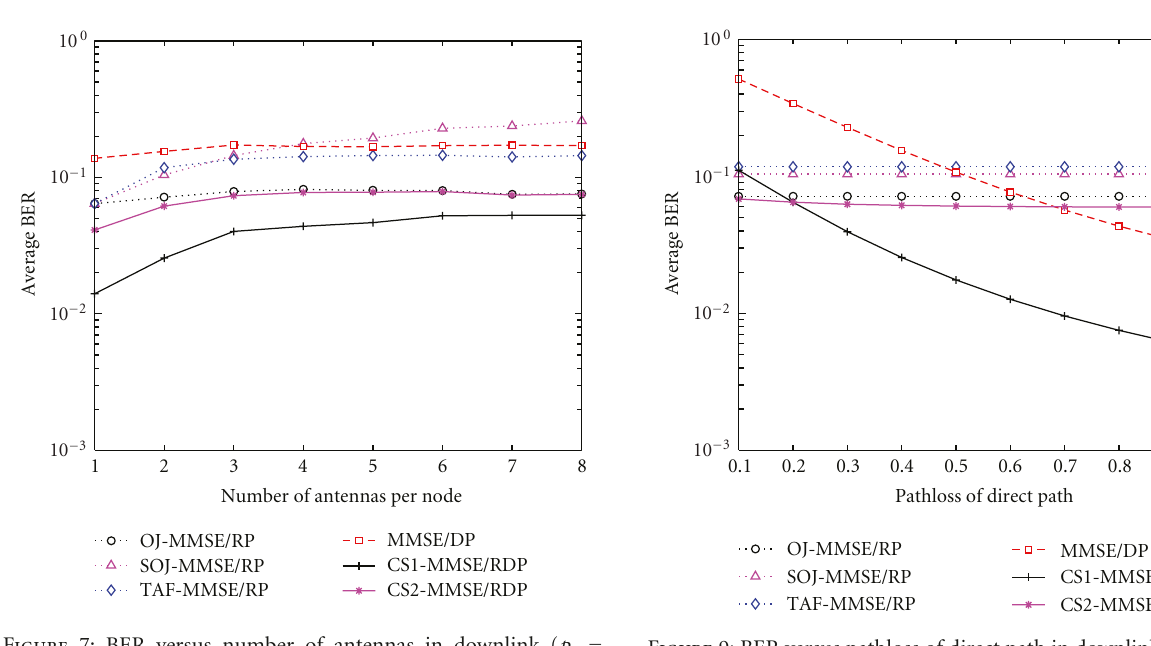
Figure 9: BER versus pathloss of direct path in downlink (SNR1 = SNR2 = 15dB) .